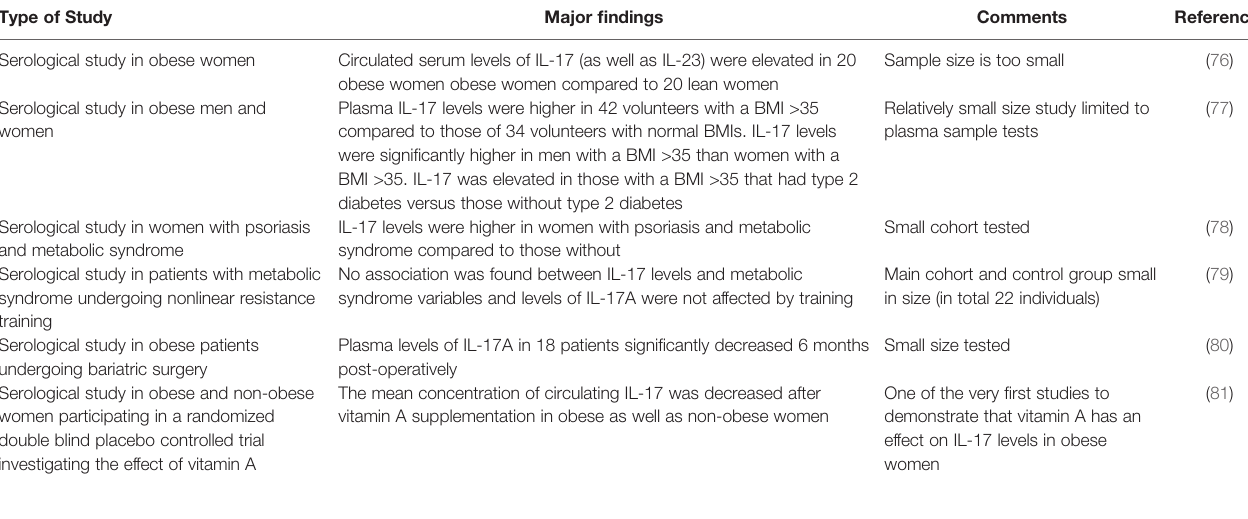
TABLE 2 | A summary of representative studies reporting on the role of IL-17 in